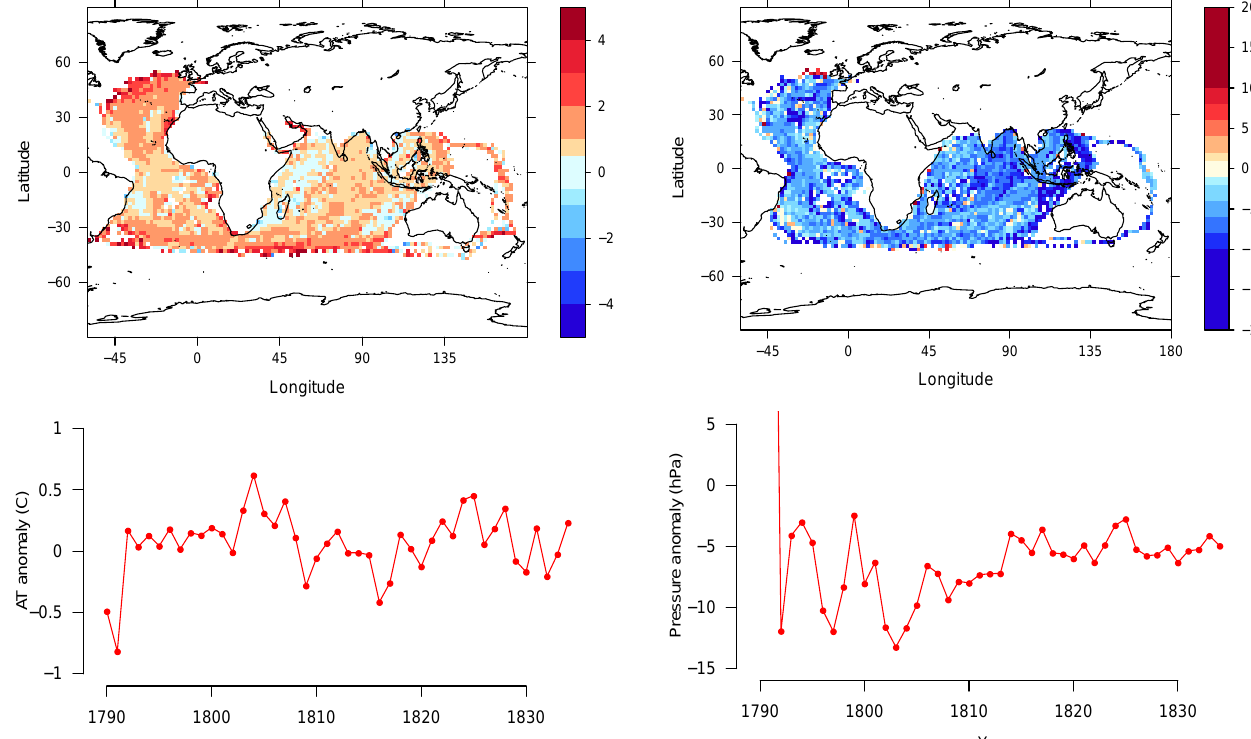
Fig. 4. Geographical coverage of the observations. Upper panel: tal number of observations in each 2x2 degree square. Lower panel: number of ships providing observations in each year.